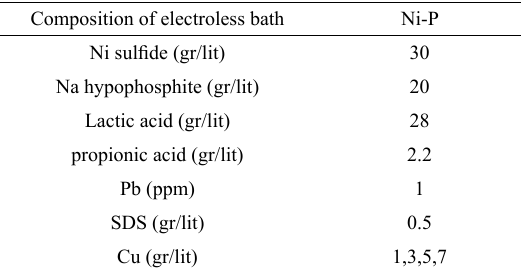
Table 3. Composition of the electroless bath for electroplating of Ni-P-Cu composite coating. Composition of electroless bath